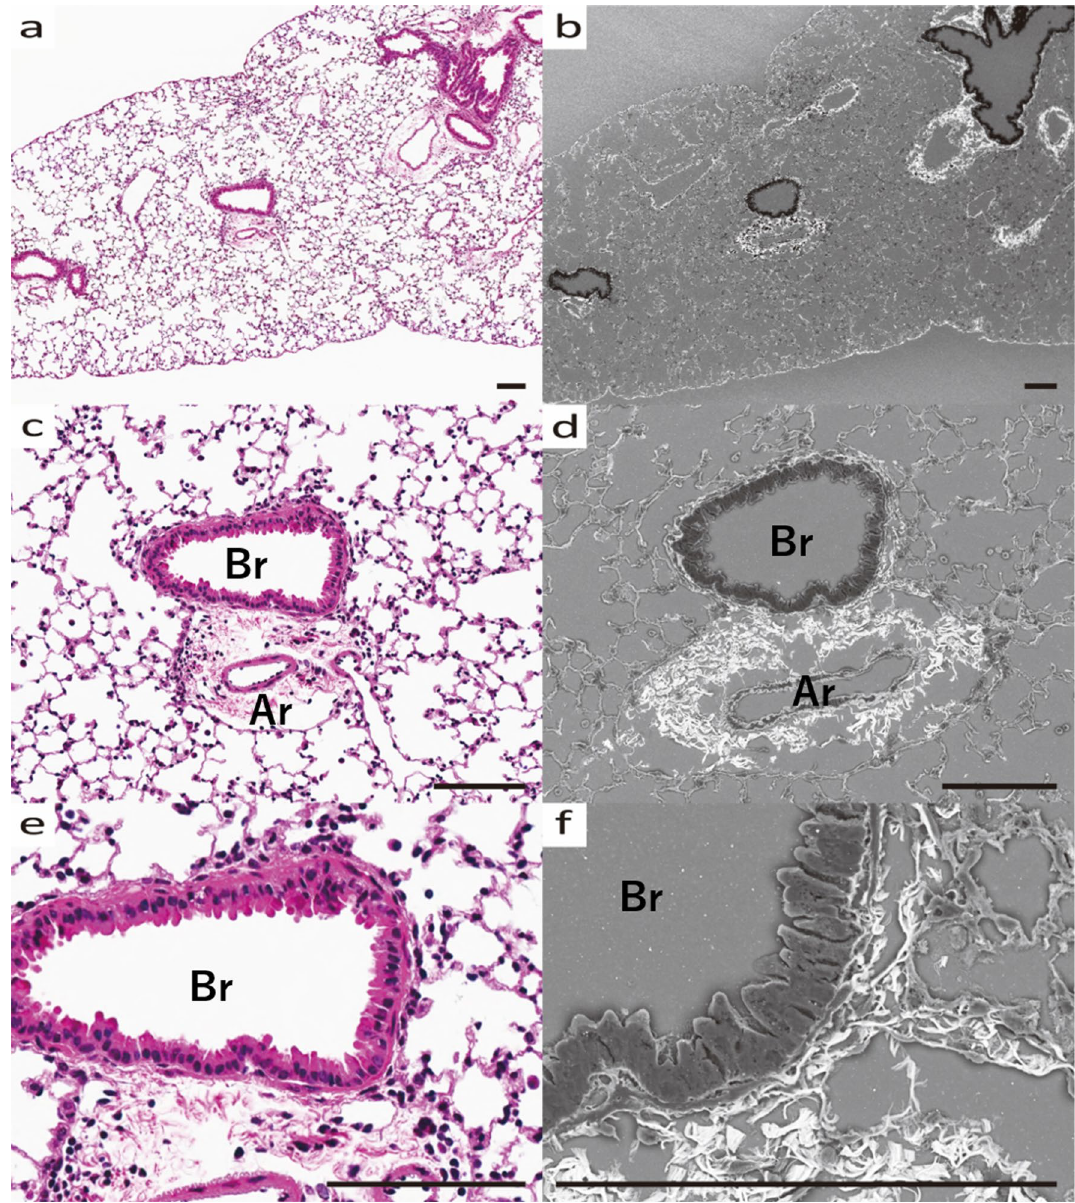
Figure 5. Bronchial tissue of HDM-sensitized AregKO mice. ( a ) Optical microscope image (HE stained) and b) SEM image (Grocott stained) of pulmonary tissue ( c ) optical microscope image (HE stained) and ( d ) SEM image (Grocott stained) of Br and Ar. ( e ) Higher magnified optical image (HE stained) and ( f ) SEM image (Grocott stained) of Br. ( a , b ) Weak peribronchial fibrosis throughout. ( c – f ) Little perivascular fibrosis and no spillover into the peribronchial area. Wide interstitial space. All scale bars show 100 μm